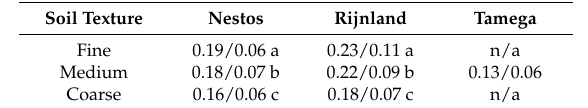
Table 3. SM means and standard deviations per soil texture class (cm 3 ¨ cm ´ 3 ).